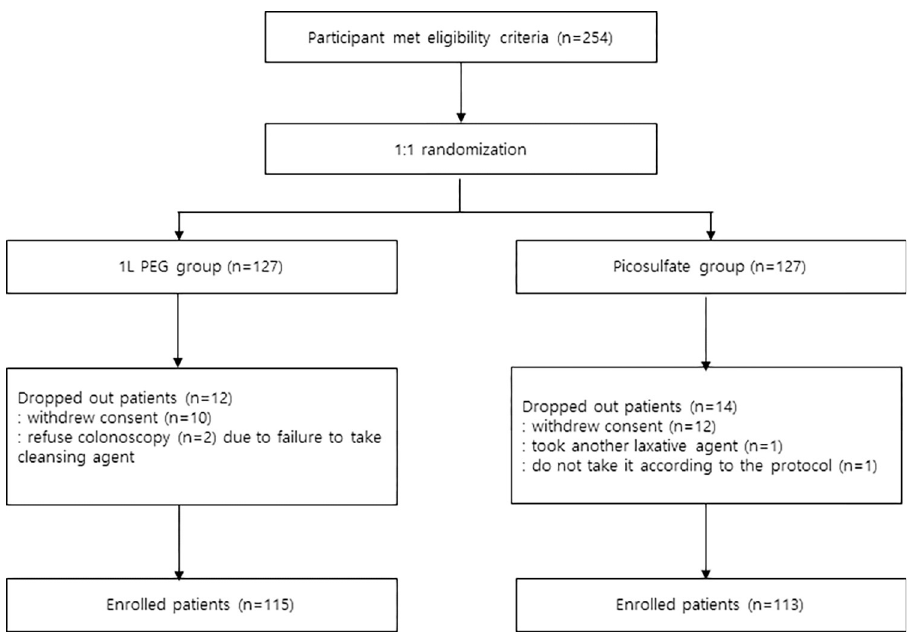
Fig 1. Flow diagram of the study. 1L PEG group, 1L polyethylene glycol with ascorbic acid group. Picosulfate group, sodium picosulfate with magnesium citrate.